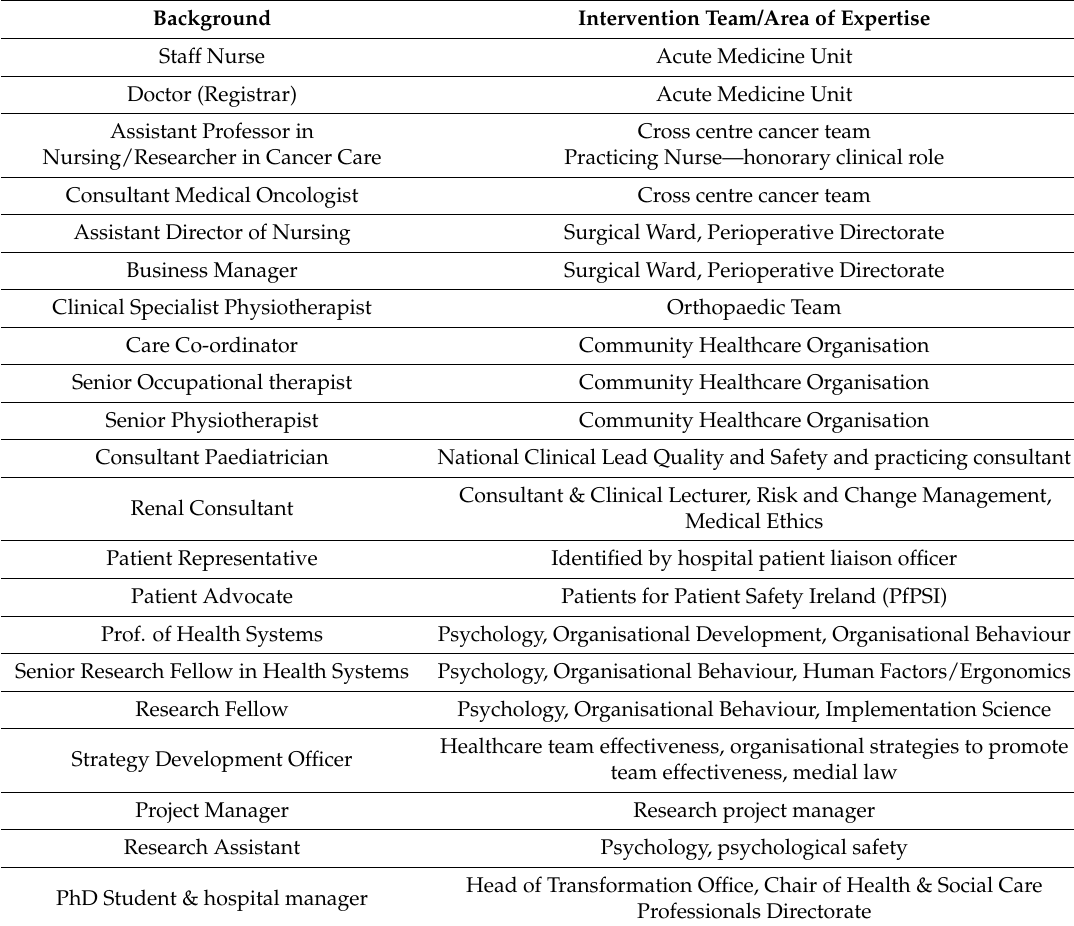
Table 1. Co-design team